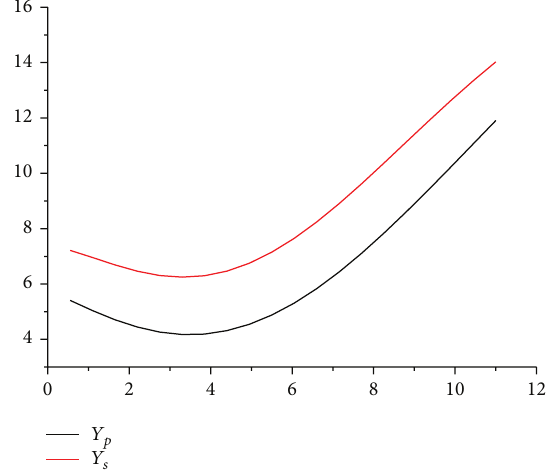
Figure 7: The preliminary profile of the blade.